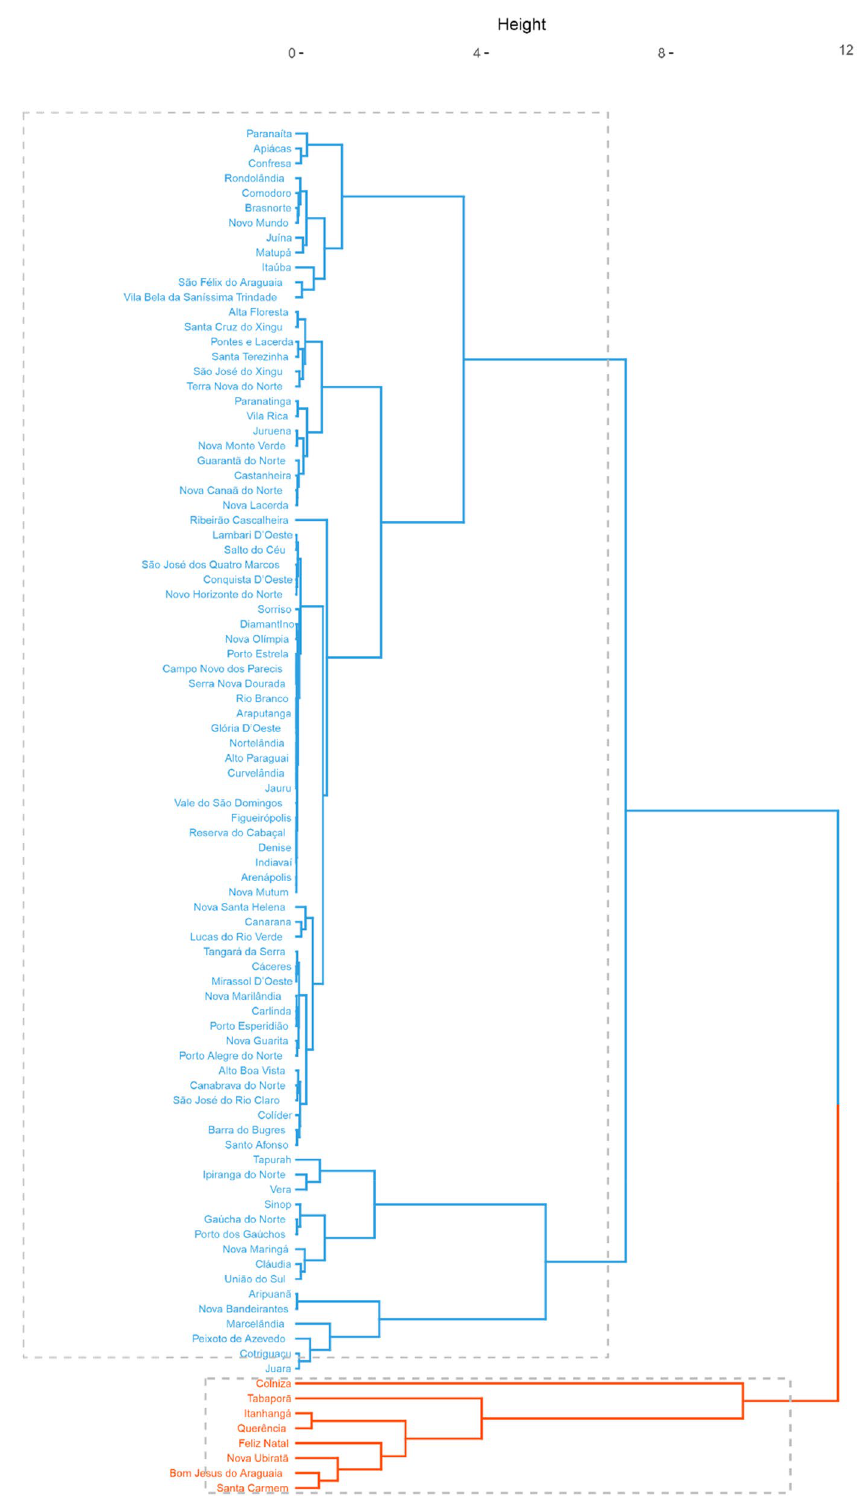
Figure 8. Cluster analysis of the municipalities of Mato Grosso based on the data of total deforestation and deforestation for soybean cultivation obtained by the PRODES